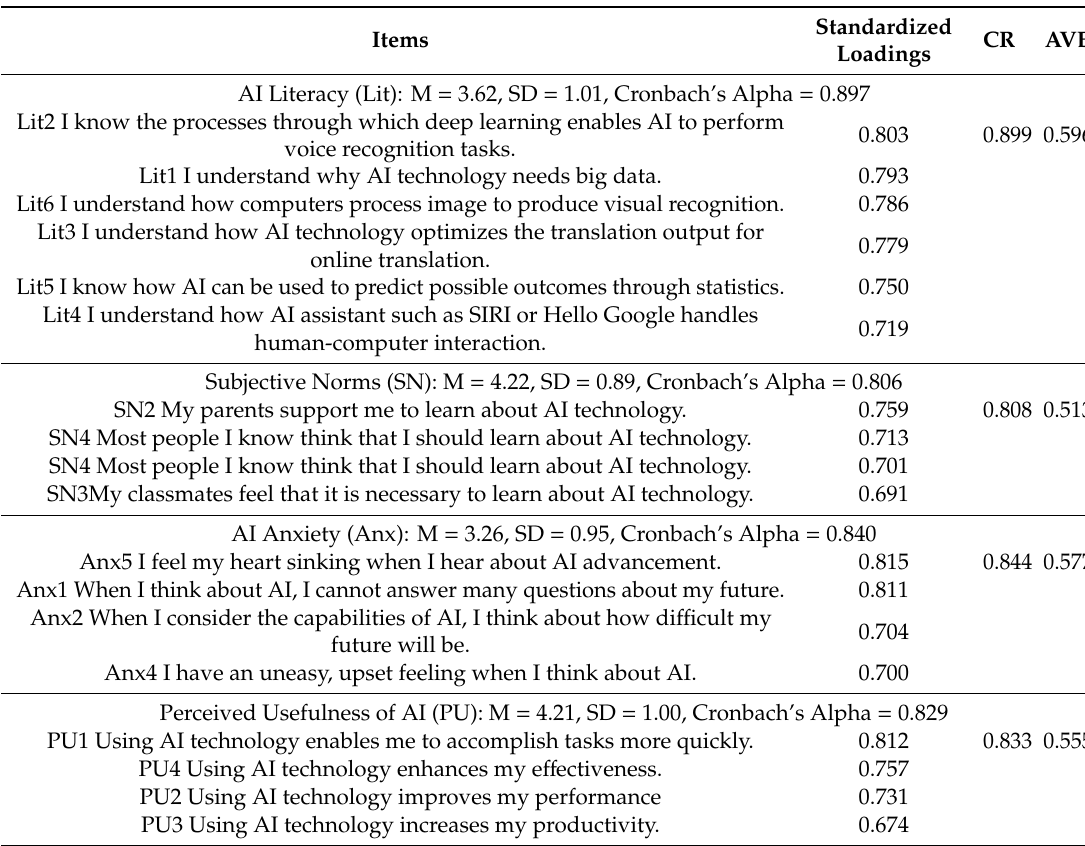
Table 1. Construct convergent